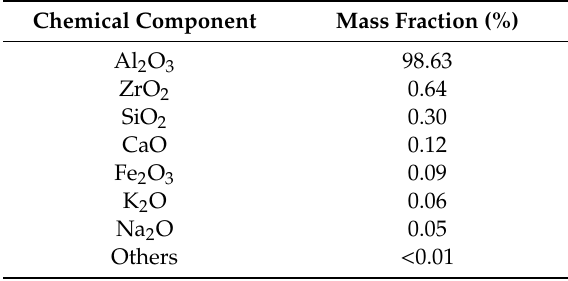
Table 2. Chemical Composition of macroporous α -Al 2 O 3